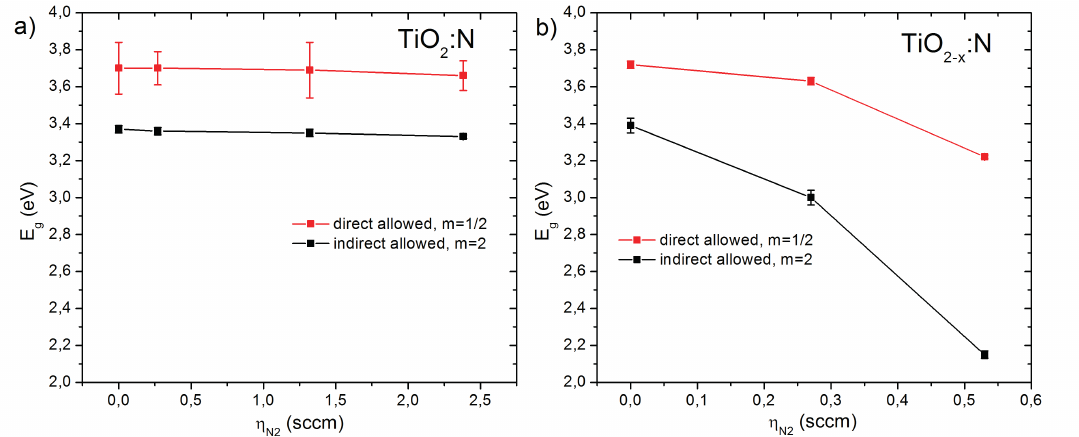
determined from optical transmittance and reflectance spectra shown in Figs. 6-7 as a function of nitrogen flow Figure 8: Energy band gap E g rate η for thin films of a) stoichiometric TiO :N (I/I =0.13) and b) non-stoichiometric TiO N2 2 0 optical transitions are